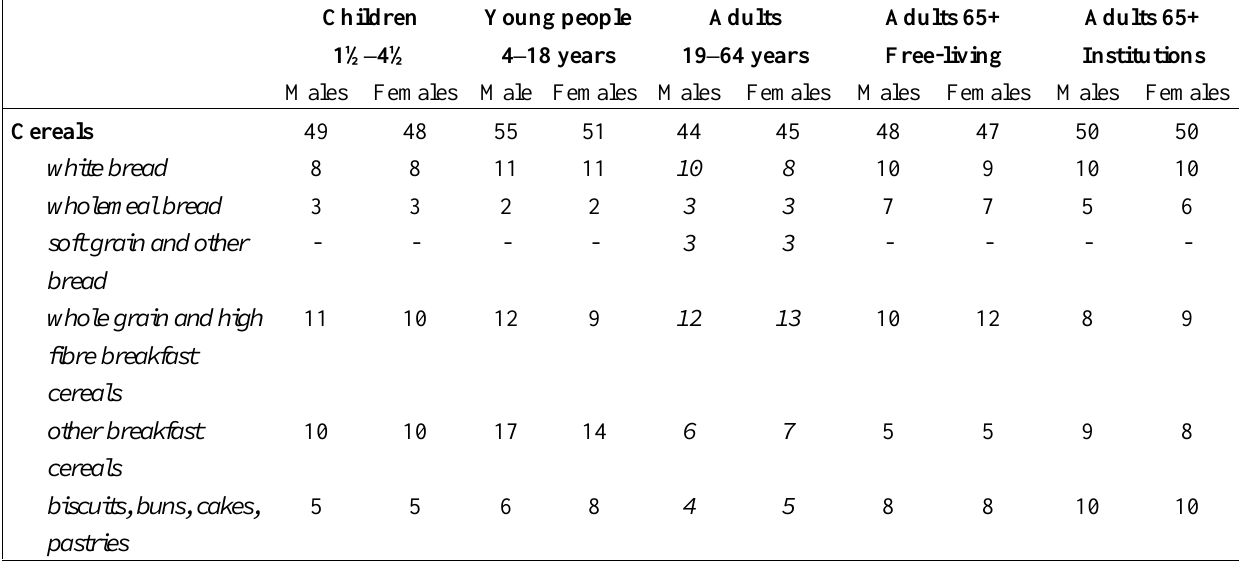
Table 7. NDNS—Contribution (%) of food types to average daily intake of total